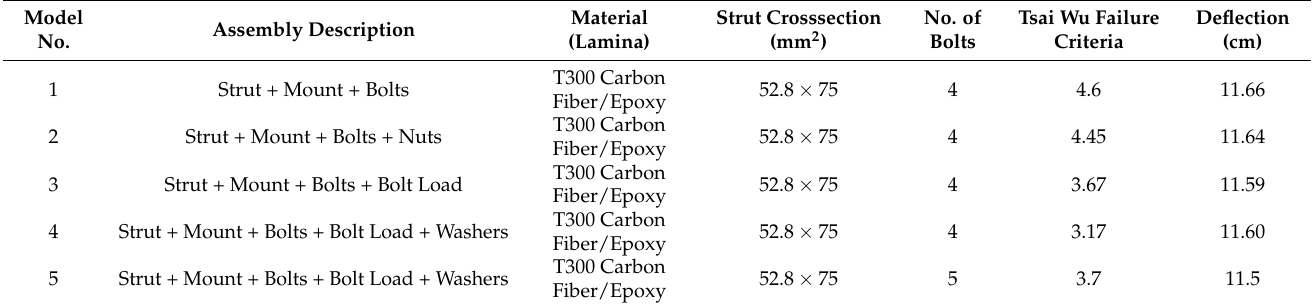
Table 9. Results of the analysis of composite MLG strut assembled with mounting.